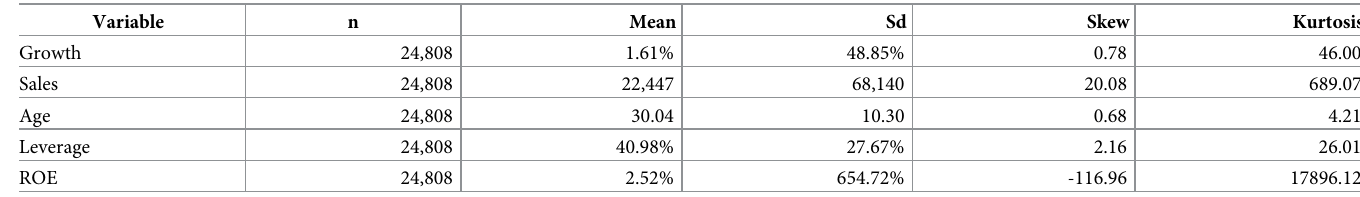
Table 1. Descriptive statistics.